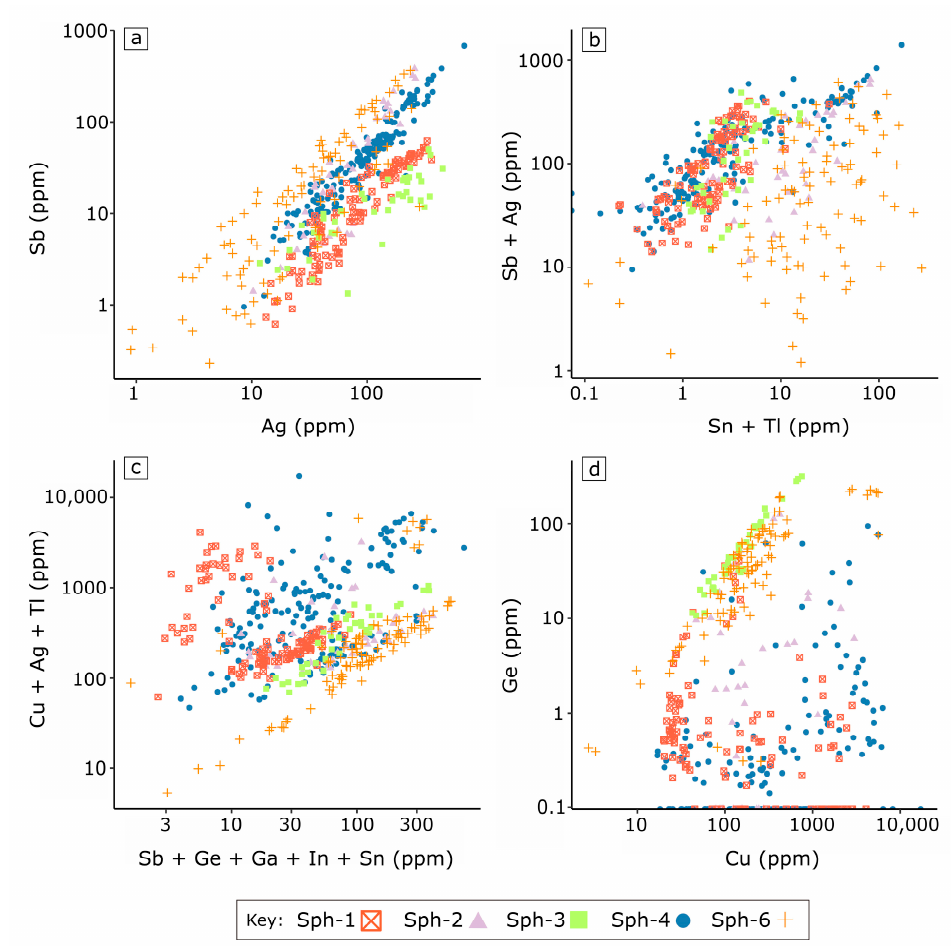
Figure 10. Binary scatter plots showing the correlation between trace elements in sphalerite and suggested substitution mechanisms. ( a ) Sb vs. Ag; ( b ) Sb + Ag vs. Sn + Tl; ( c ) Cu + Ag + Tl vs. Sb + Ge + Ga + In + Sn; ( d ) Ge vs. Cu.